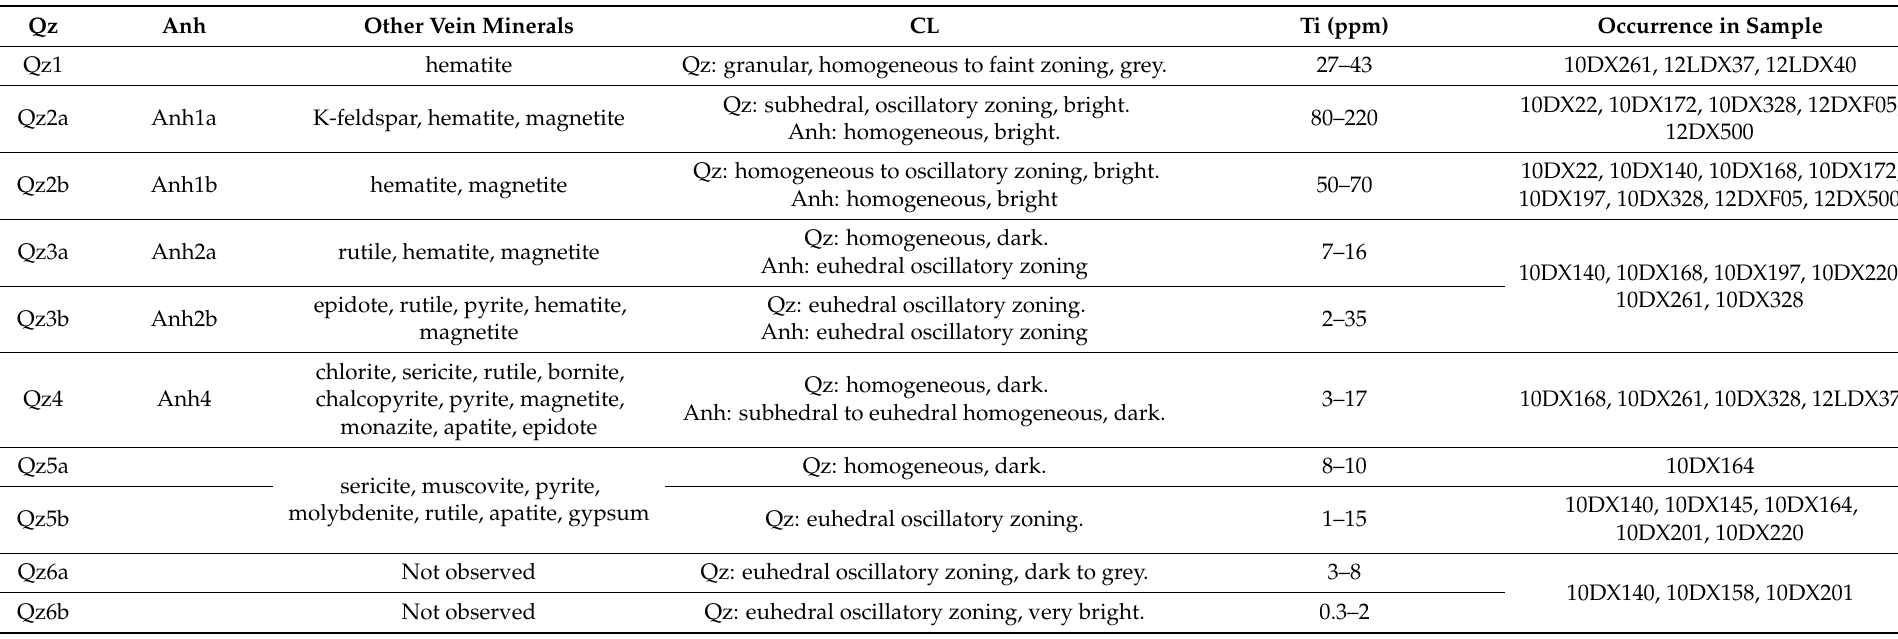
Table 2. A summary of generations, CL textures, mineral assemblages and Ti contents of quartz and anhydrite of the Tongchang porphyry Cu